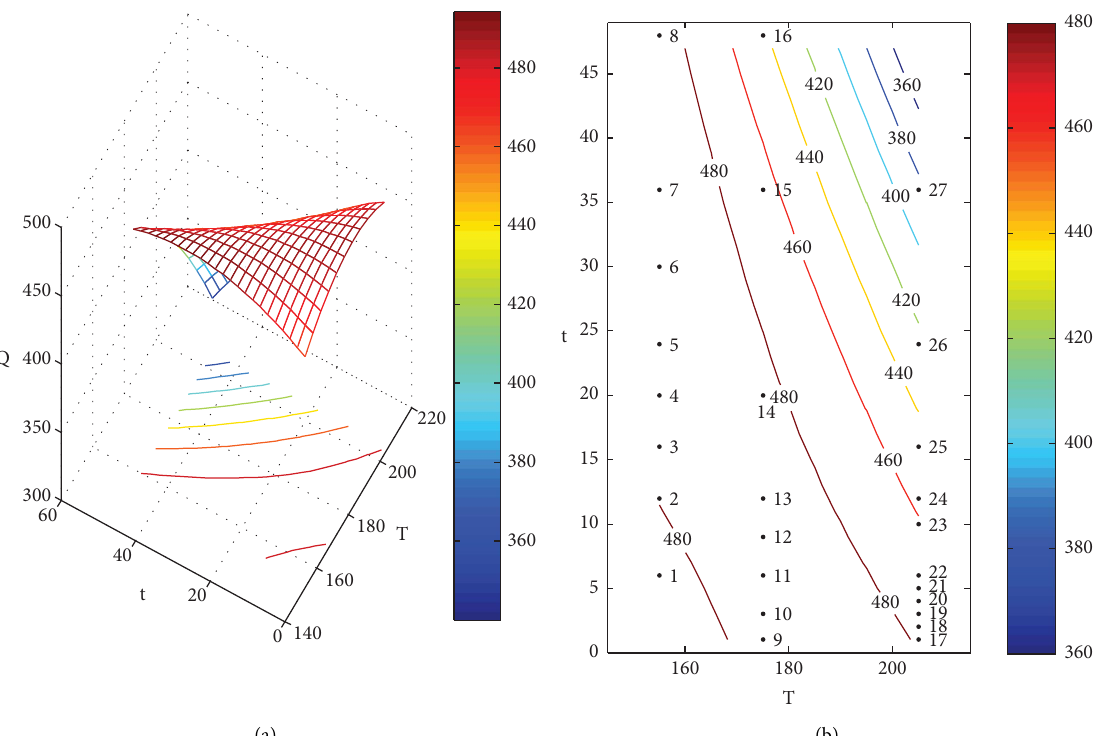
Figure 5: 3D surface graph of the regression model (a) and quality map (b) for (Q) of cast aluminum alloy A357 according to artifcial aging heat treatment condition.